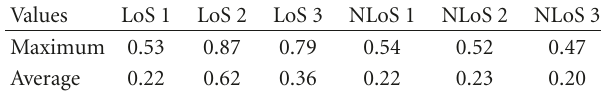
Table 1: Amplitude of correlation coe ffi